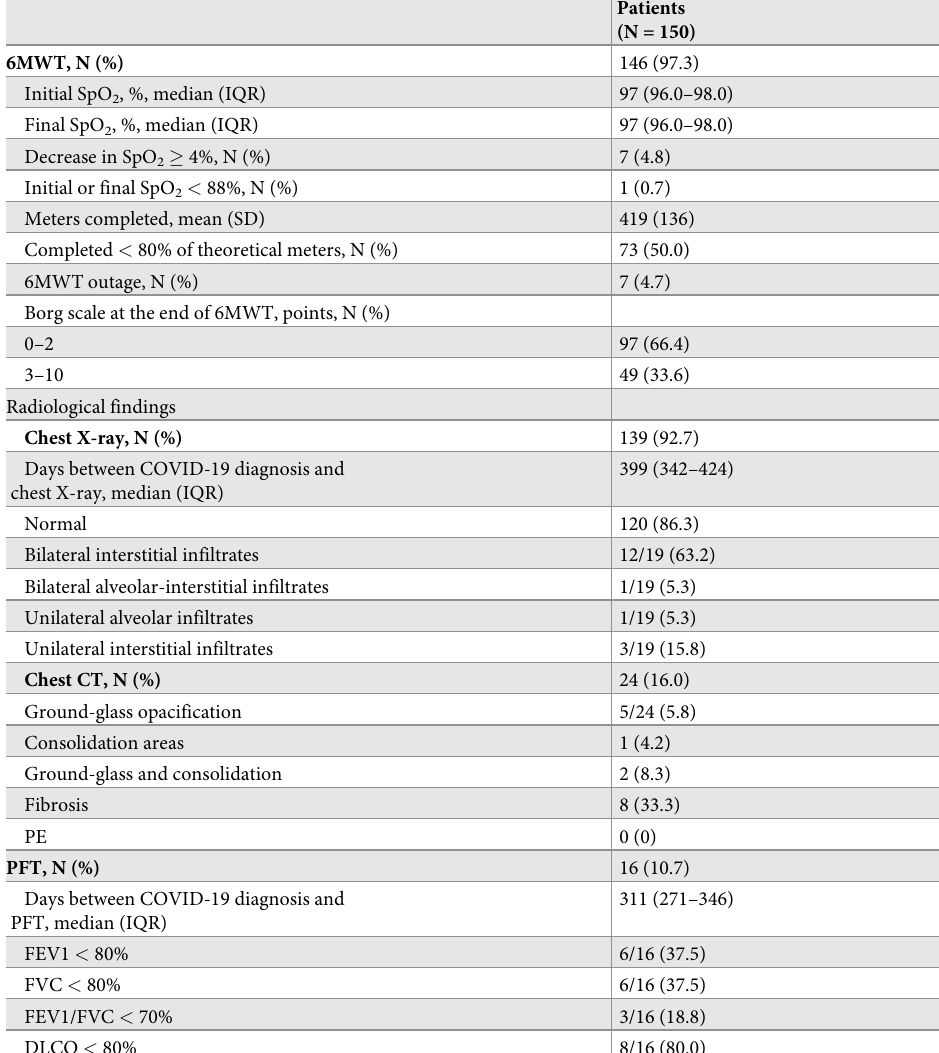
Table 3. 6MWT, radiological, and PFT results at